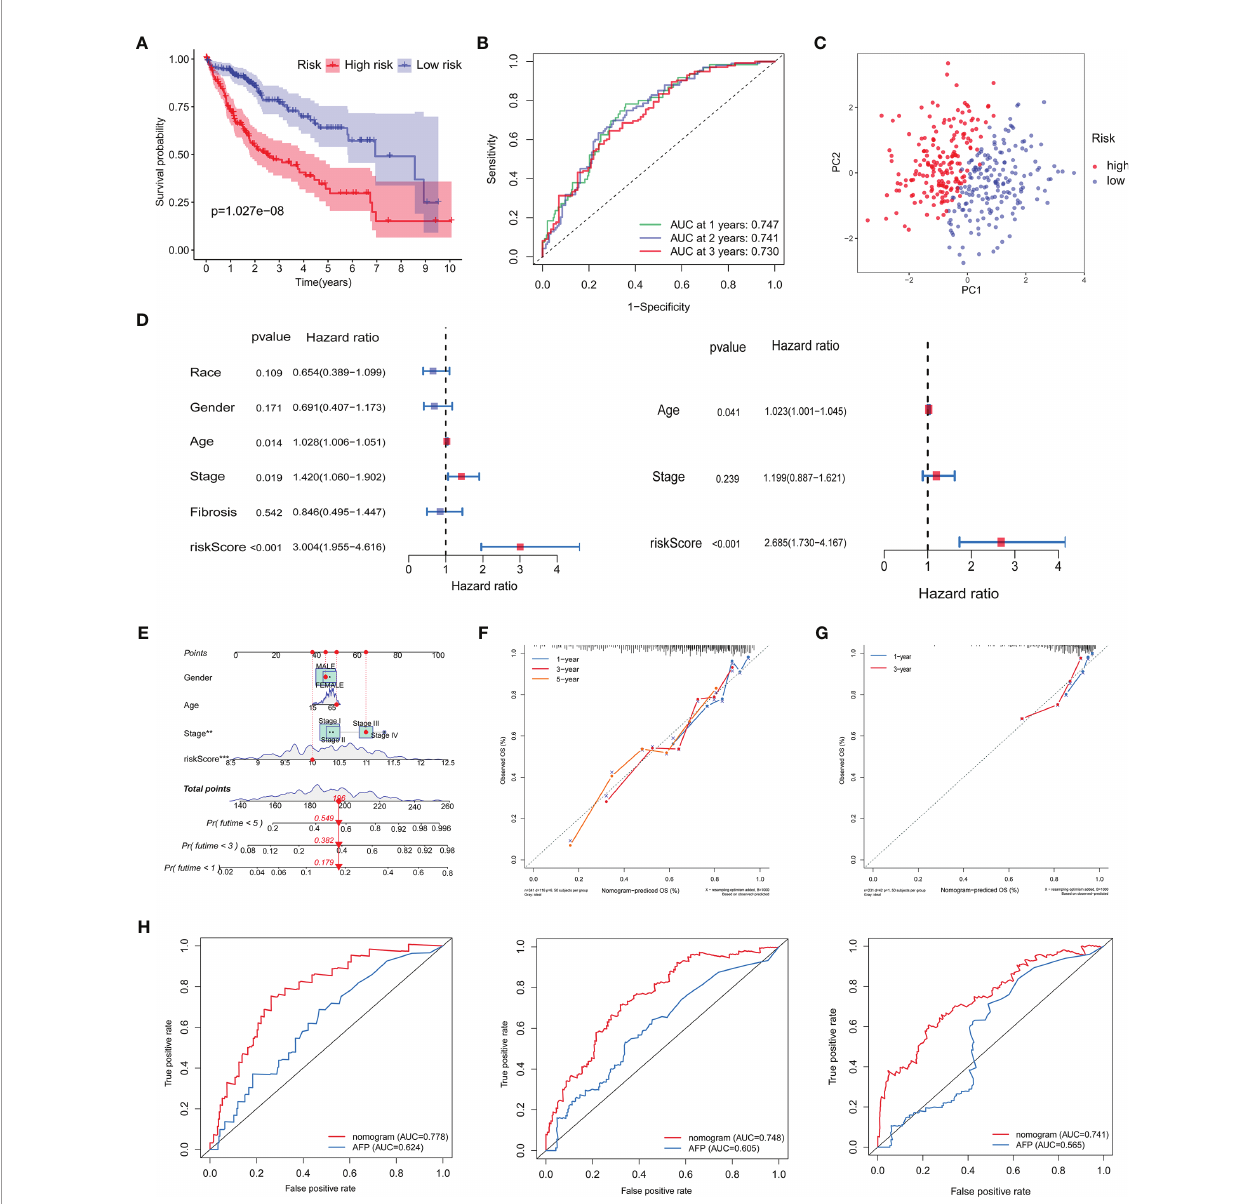
FIGURE 8 | Validation of the prognostic signature and establishment of a novel nomogram. (A) Kaplan – Meier curve analysis of the low- and high-risk groups. (B) ROC curve showing the prognostic risk model. (C) PCA plot of TCGA-LIHC patients in different risk groups. (D) Univariate and multivariate independent prognostic analysis of clinical features and risk scores. (E) Nomogram for survival prediction in TCGA-LIHC. (F, G) Nomogram calibration curves of 1-, 3-, and 5-year survival probabilities in TCGA-LIHC and ICGC-LIRI-JP, respectively. (H) ROC curves of the nomogram and AFP for the survival prediction at 1-, 3-, and 5-years. ROC, receiver operating characteristic; AUC, areas under the receiver operating characteristic curve; PCA, Principal component analysis; AFP, alpha- fetoprotein; OS overall